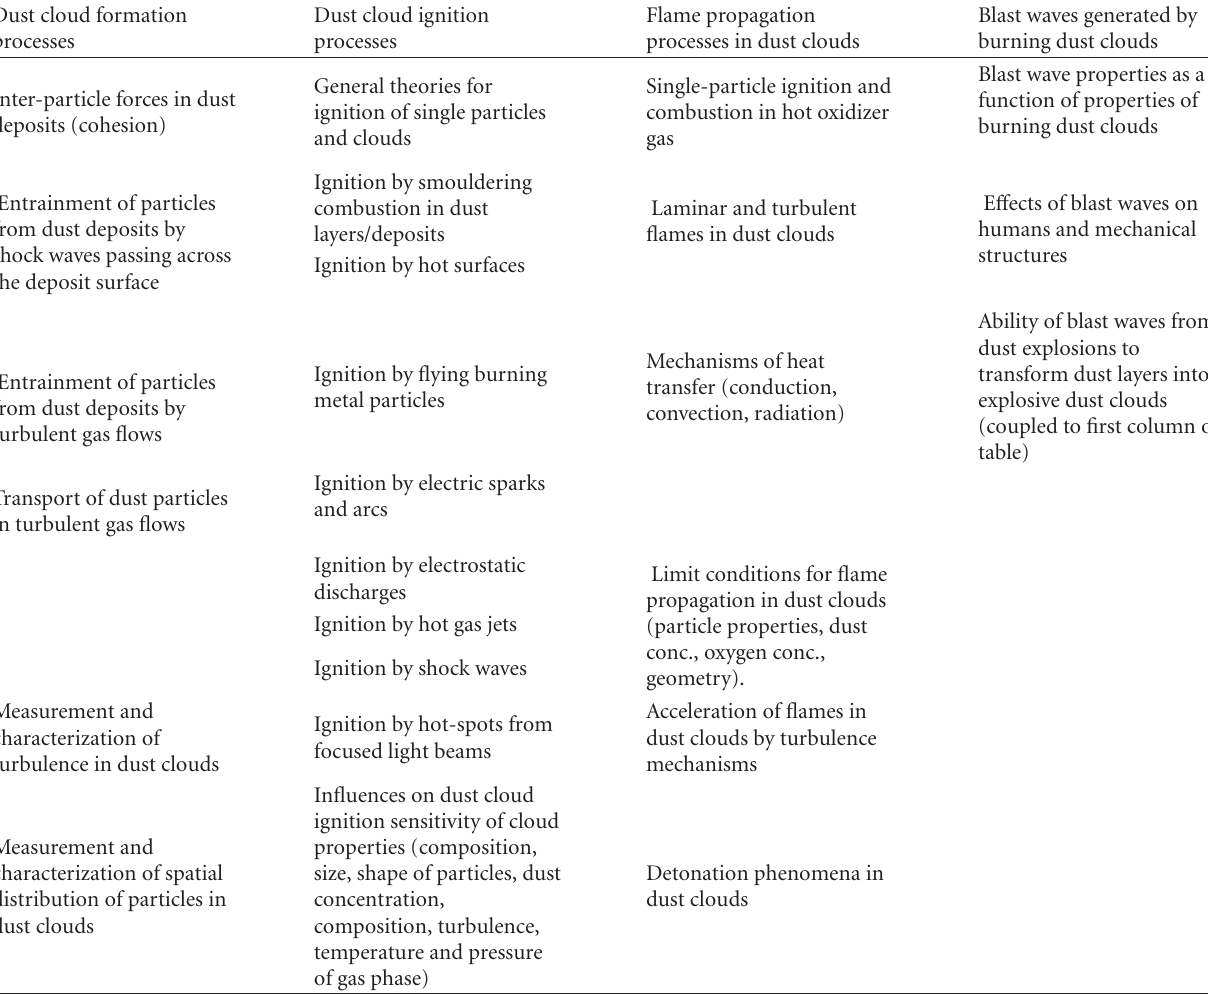
Table 2: Fundamental aspects addressed in dust explosion